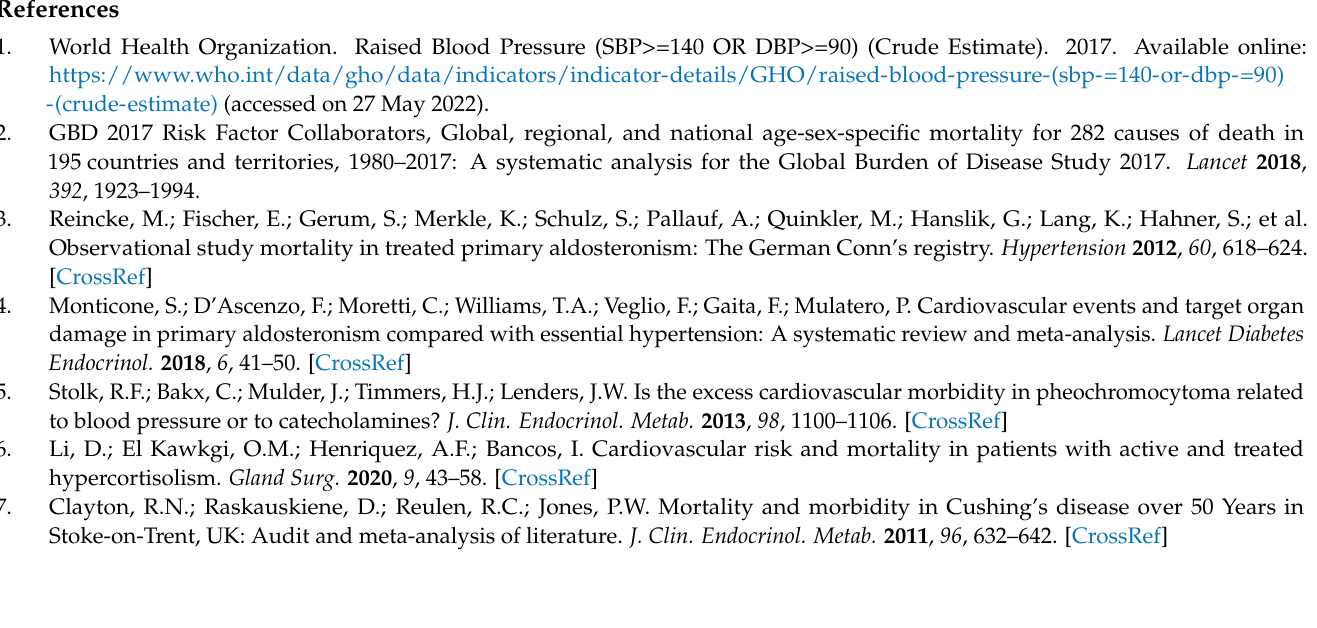
pH 2.5. Table S2: Summary of accuracies from analyses done via the Initial Approach, without correcting for confounders. Table S3: Summary of accuracies from analyses done via Approach A (ASCA correction). Table S4: Summary of PLSDA analyses done to compare groups of samples defined by confounders. Table S5: Summary of accuracies from analyses done via Approach B (after the exclusion of peaks related to confounders). Table S6: Summary of accuracies from analyses done via approach C (whole center exclusions). Table S7: Summary of accuracies from analyses done to evaluate datasets used in approach C (whole center exclusions). Reference [84] is cited in